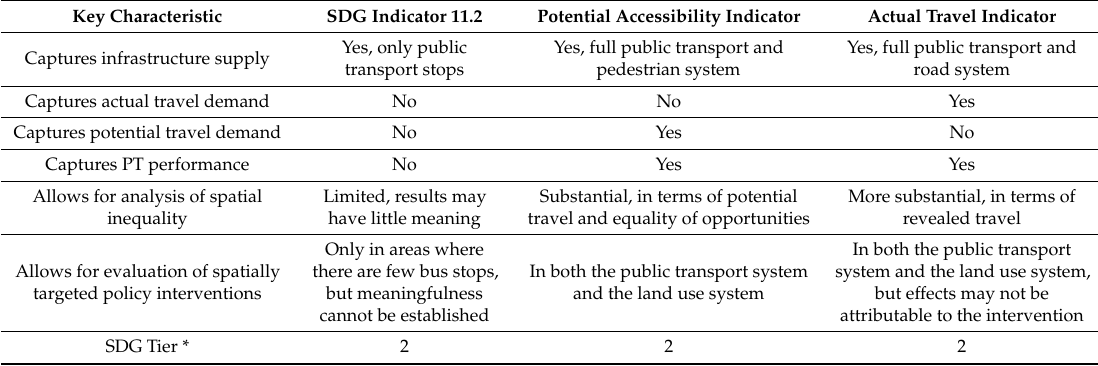
Table 5. Overview of indicators against key characteristic (* = authors categorization, methodology established, data not regularly